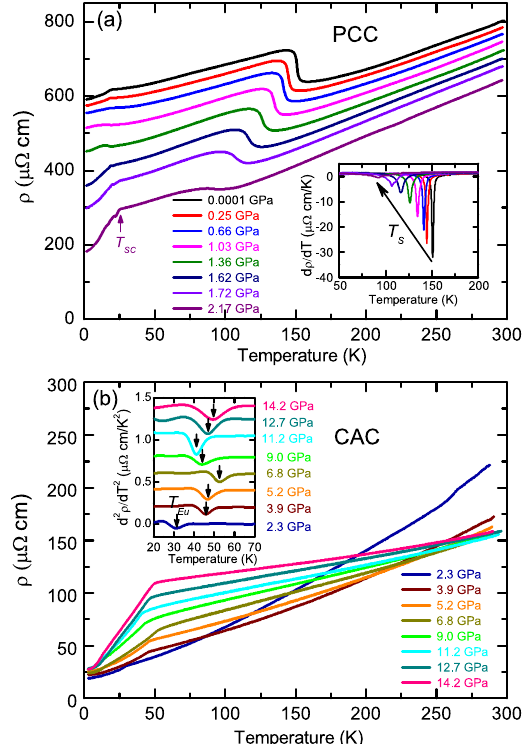
Figure 1. Temperature dependencies of the electrical resistivity ( ρ ) of the Eu(Fe 0.925 Co 0.075 ) 2 As 2 single crystals measured under high pressures with the piston-cylinder cell ( a ) and the cubic anvil cell ( b ),